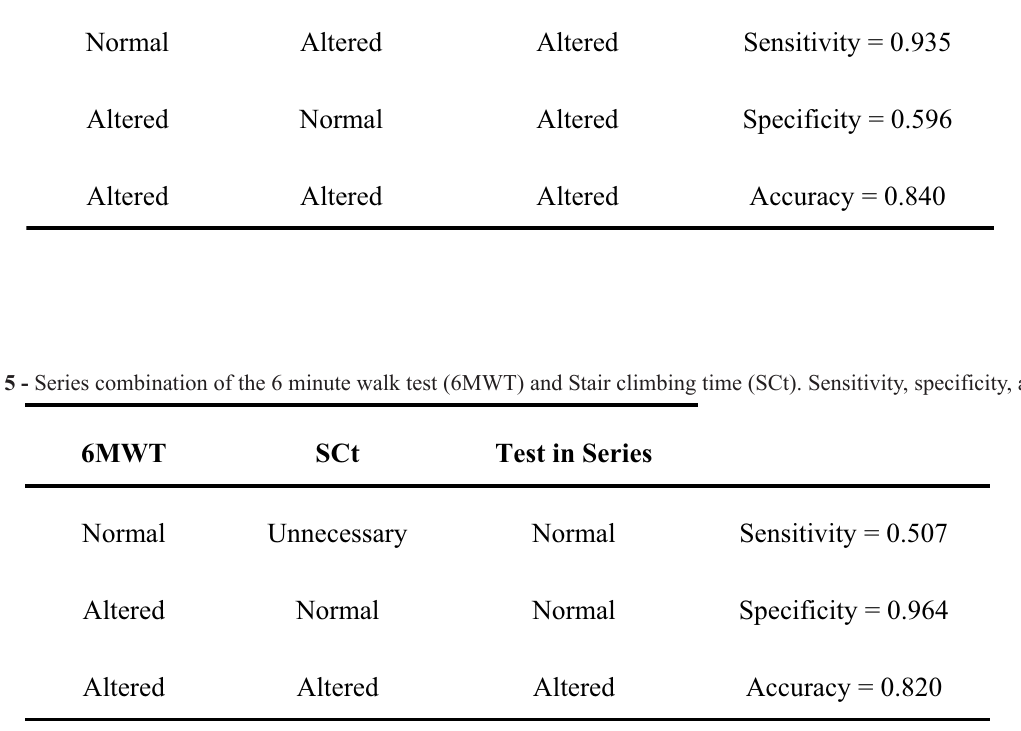
As 6MWT distance and stair-climbing time had the best accuracy and concordance, they were combined in parallel and in series. Parallel combination yielded 93.5% sensitivity, 59.6%